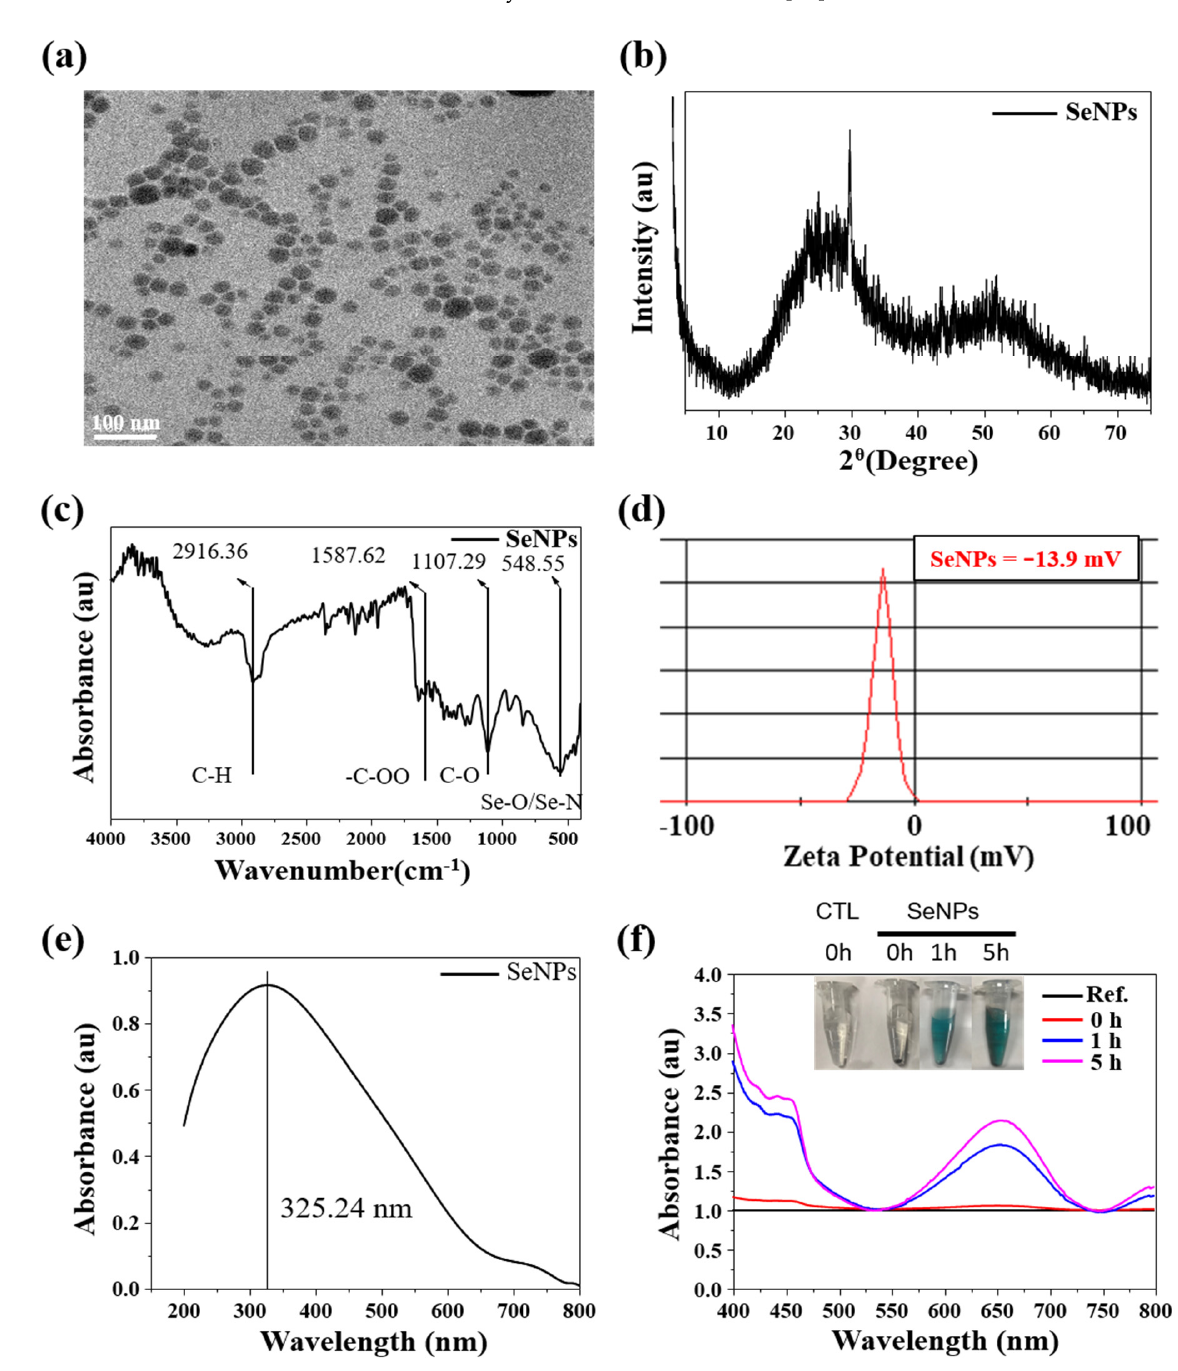
Figure 1. Characterizations of SeNPs. ( a ) TEM image of SeNPs, ( b ) XRD patterns, ( c ) FT-IR spectra of SeNPs, ( d ) ζ -potentials of SeNPs, and ( e ) UV-visible spectra of SeNPs in DW. ( f ) Optical image of the SeNPs reaction with TMB at 0 h, 1 h, and 5 h; the corresponding change in color (SeNPs concentration in 200 µ g/mL and TMB concentration in 200 µ g/mL) at pH 4.0 in DW; and UV-visible absorption spectra of TMB (before reaction as a reference) and after reaction for 0 h, 1 h, and 5 h with and without SeNPs.